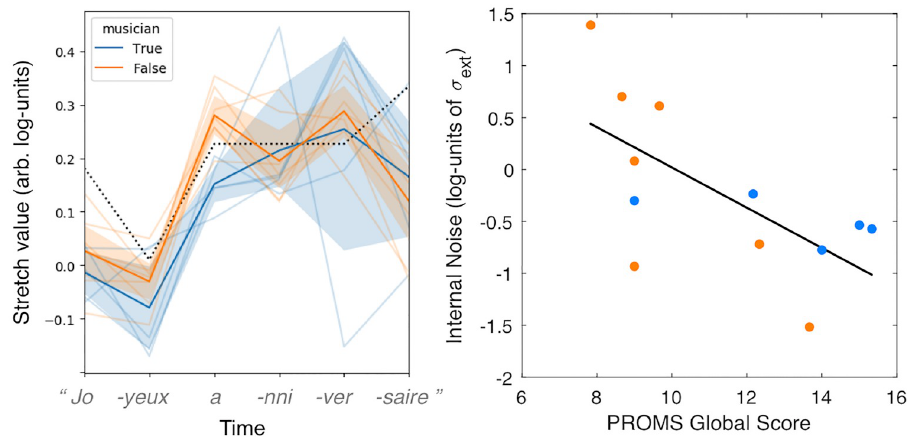
Fig 5. Mental representation of the rhythm of a well-known song. Left: Average first-order kernel derived by reverse-correlation on N = 12 participants, superimposed with the theoretical pattern (dotted line), showing how the internally represented pattern departed from the theoretical one. Right: log-values of internal noise estimated from the double-pass technique are negatively correlated with the participant’s degree of musical skills (average score obtained for the 3 sub-tests of PROMS); r = -0.65, p =